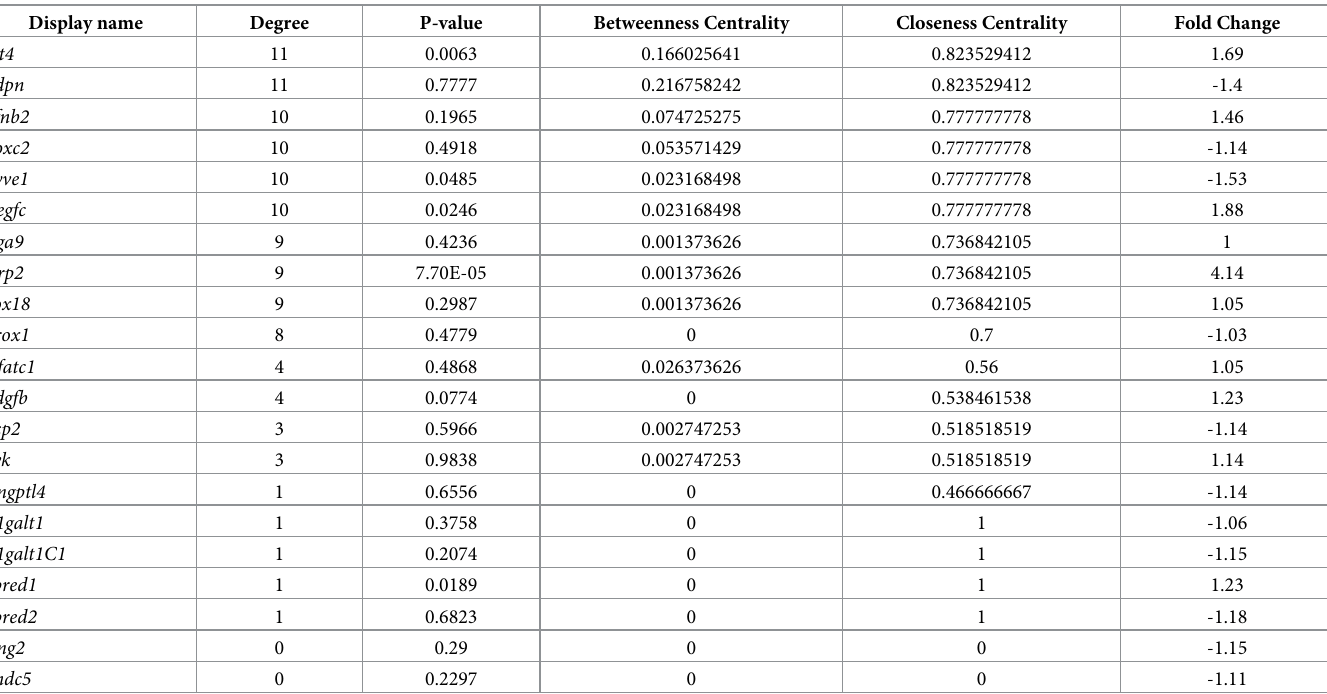
Table 4. Interaction degree of the protein-protein interaction network for the lymphangiogenesis pathway gene set. ( n = 3 for each group). Display